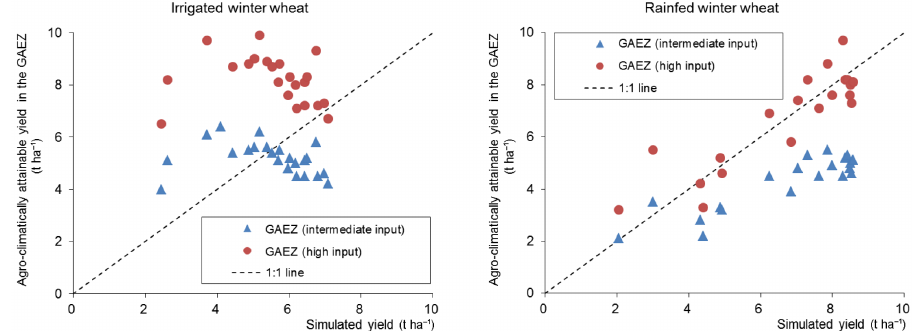
Figure 8. Comparison between the simulated yield of winter wheat and the agro-climatically attainable yield according to FAO/IIASA (2011) at provincial level in China. Averaged over the period